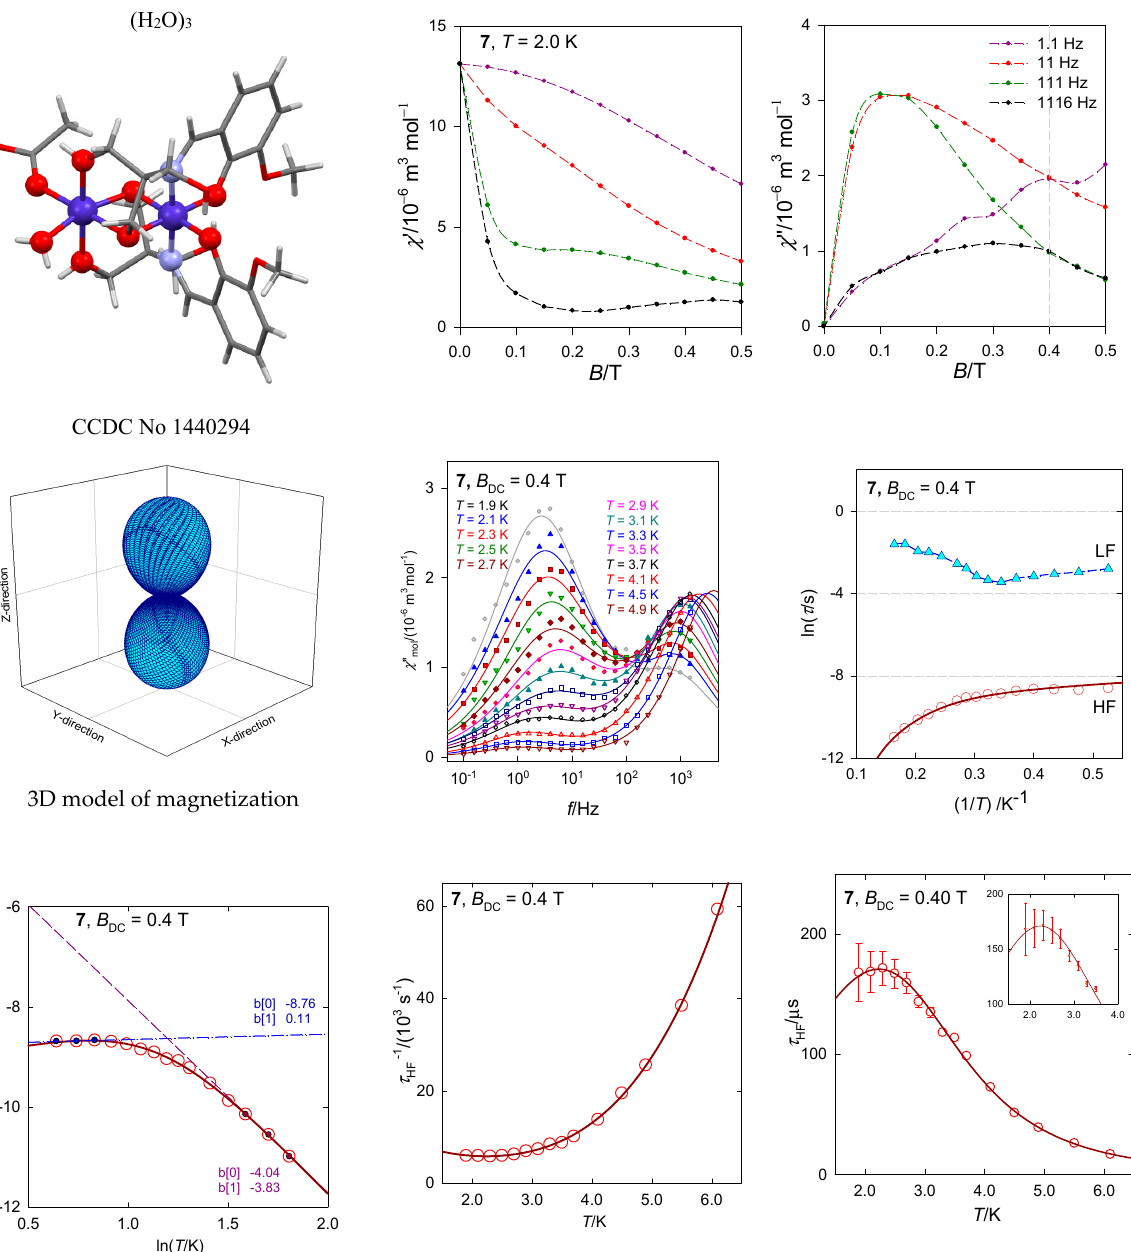
Figure 15. AC susceptibility data for 7 . Full lines—fitted. Data adapted from ref. [35]. 2017, American Chemical Society.